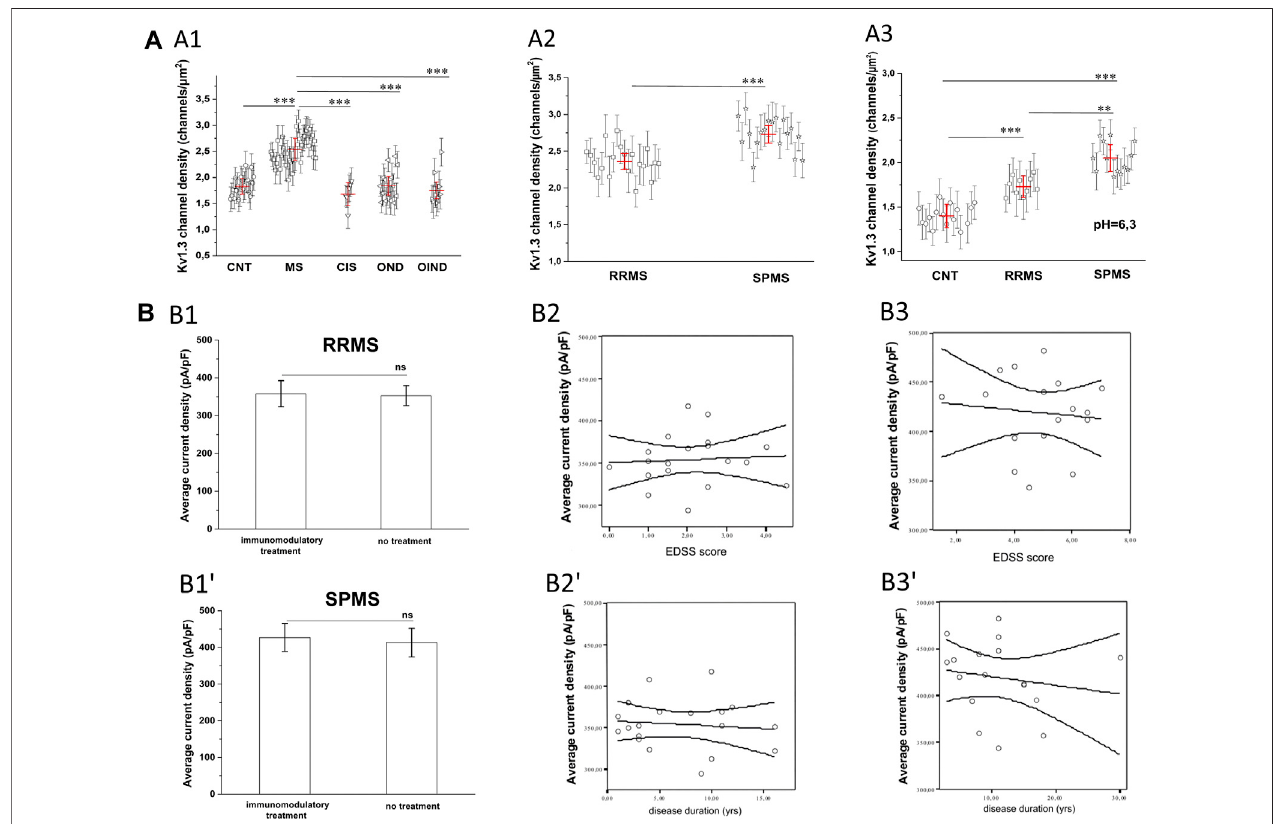
FIGURE3|(A) :CalculatedK V 1.3channeldensitiesperTlymphocytefromwhole-cellcurrentsrecordedfromaholdingpotentialof − 90 mV. (A1): K V 1.3channeldensitiesin MSpatients( n (cid:1) 38,N (cid:1) 852cells)aresigni fi cantlyhigher( p < 0.001),comparedtohealthycontrolsubjects( n (cid:1) 21,N (cid:1) 540cells),patientswith:clinicallyisolatedSyndrome(CIS) ( n (cid:1) 6,N (cid:1) 130cells),otherneurologicaldisorders(OND)( n (cid:1) 16patients,N (cid:1) 335cells),andotherin fl ammatoryneurologicaldisorders(OIND)( n (cid:1) 9patients,N (cid:1) 253cells).Each symbol represents mean values for each individual patient and error bars are standard deviation of the mean. Red horizontal lines with red error bars correspond to the average value ± standard error for each group. Comparisons are shown only for statistically signi fi cant differences ( ٭٭٭ : p < 0.001). One way ANOVA with Bonferroni post hoc correction was applied for statistical analysis. (A2): Sub-grouping of MS patients showed signi fi cantly higher K V 1.3 channel densities in Secondary ProgressiveMultipleSclerosis (SPMS)( n (cid:1) 18patients,N (cid:1) 415cells),comparedtoRelapseRemittingMultipleSclerosis(RRMS)( n (cid:1) 20patients.N (cid:1) 440cells).Valuesshownaremean ± SDforeachsubject. Red horizontallinescorrespond to theaveragevalue ± standard errorfor each group. ( p < 0.001).( ٭٭٭ : p < 0.001). (A3) In acidicextracellularsolution,whereTASK-2activation is negligible, Kv1.3 channel densities are signi fi cantly higher in T cells of patients with SPMS ( n (cid:1) 12, N (cid:1) 230 cells), compared to both RRMS ( n (cid:1) 12, N (cid:1) 252 cells) and healthy controls( n (cid:1) 14,N (cid:1) 310cells).Individualmarksrepresentmean ± SDforeachsubject;redhorizontallinesandbarsrepresentaverage ± SE.( ٭٭٭ : p < 0.001, ٭٭ : p < 0,01). (B) .Effect of MS severity (MMSE score), duration (years) and immunomodulatory treatment on K V 1.3 current density. (B1-B1 9 ) . K V 1.3 density was not affected by immunomodulatory treatmentinRRMS[treated:357.7 ± 34 pA/pF,( n (cid:1) 14);untreated:350.2 ± 27 pA/pF,( n (cid:1) 6),]orSPMSpatients[treated:426.8 ± 38.3 pA/pF( n (cid:1) 13);untreated:412.9 ± 39 pA/ pF,( n (cid:1) 5)].Averagevalues ± SEareshown(ns:non-signi fi cant). (B2 – B2 9 ). InRRMS,K V 1.3currentdensitydidnotcorrelatewitheitherEDSS(r 2 (cid:1) 0.05, p (cid:1) 0.7)ordiseaseduration (r 2 (cid:1) 0.1, p (cid:1) 0.3). (B3-B3 9 ). In SPMS, correlations were also non-signi fi cant for either EDSS (r 2 (cid:1) 0.11, p (cid:1) 0.5) or disease duration (r 2 (cid:1) 0.16, p (cid:1)